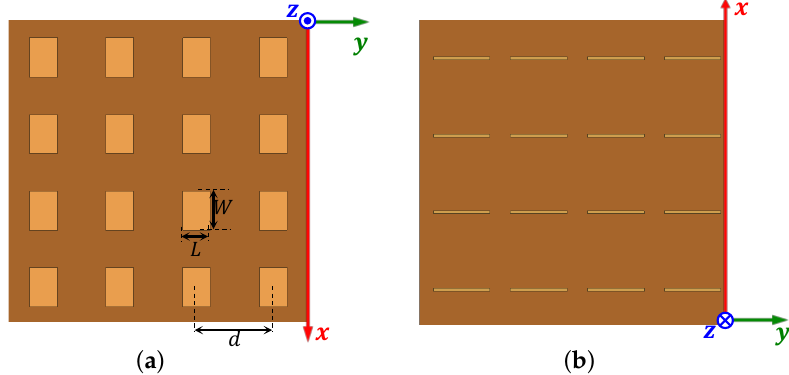
Figure 19. ( a ) Top and ( b ) bottom geometries of the 4 × 4 finite array of rectangular microstrip-patch antennas that are terminated and virtually connected in the van Atta configuration in the xz